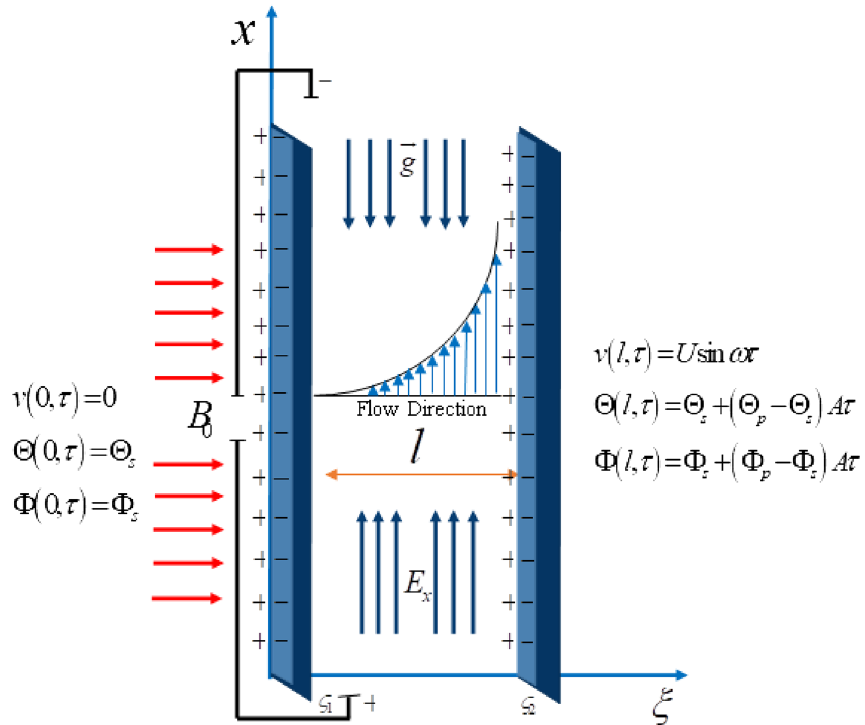
Figure 1. Geometrical illustration of